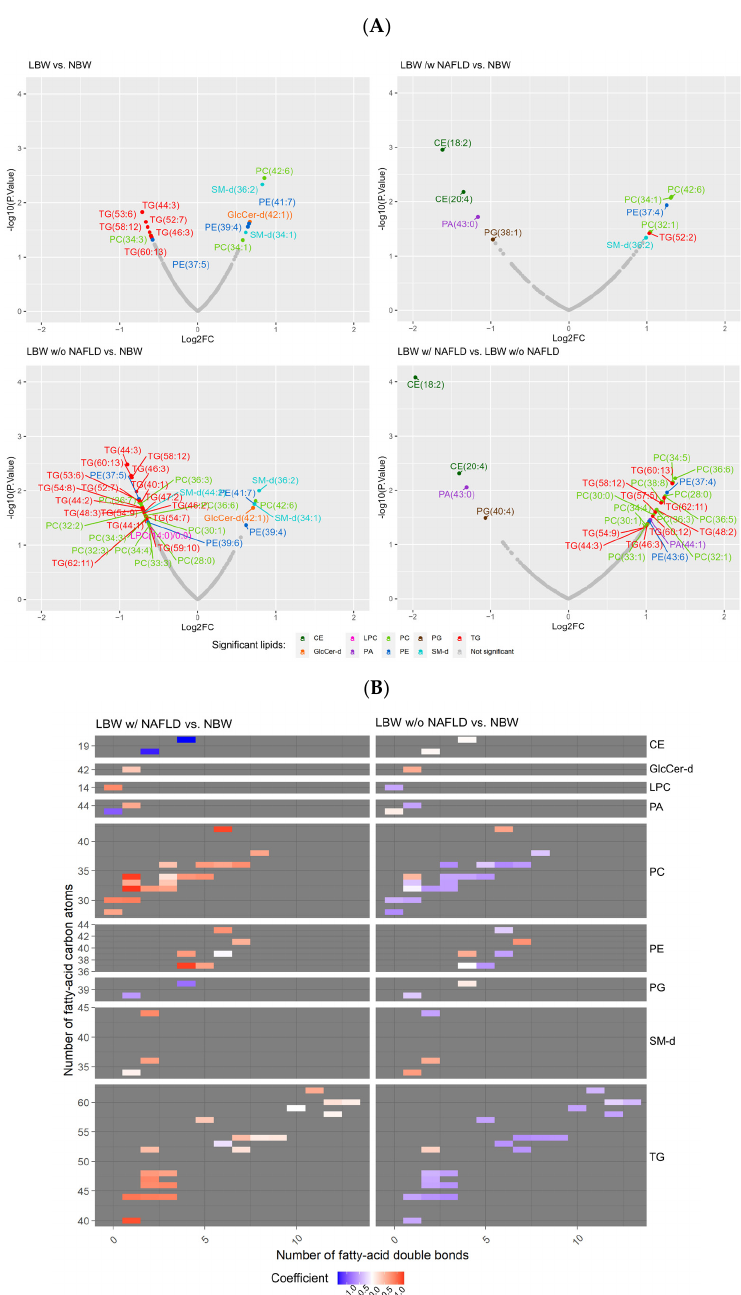
Figure 2. Lipidomics analyses revealed differences in lipid subclasses and lipid composition in LBW subjects with NAFLD compared with NBW subjects and LBW subjects w/o NAFLD. ( A ) Volcano plots illustrating the differentially abundant lipid species across the four abundance analyses. Log fold changes (Log2FC) are plotted on the x -axis and log10( p -value) on the y -axis. All plots use a p -value cutoff of p ≤ 0.05. Only significant lipids are denoted with their corresponding name. Lipid sub-classes are color-coded as shown in the legend. ( B ) Structural heatmaps for each lipid class including the 56 lipids of interest. Each lipid species is shown as a rectangle and the color shows the abundance difference between LBW subjects w/NAFLD compared with NBW subjects (left column) and LBW subjects w/o NAFLD compared with NBW subjects (right column). Red indicates an increased abundance and blue a decreased abundance. Lipids are organized by the level of saturation (number of double bonds) on the x -axis and the chain length (total number of carbon atoms) on the y -axis. To estimate the length of each fatty acid chain, the summarized number is divided by the number of fatty acid chains of the lipid species (e.g., TGs are divided by three, as this group contains three fatty acid